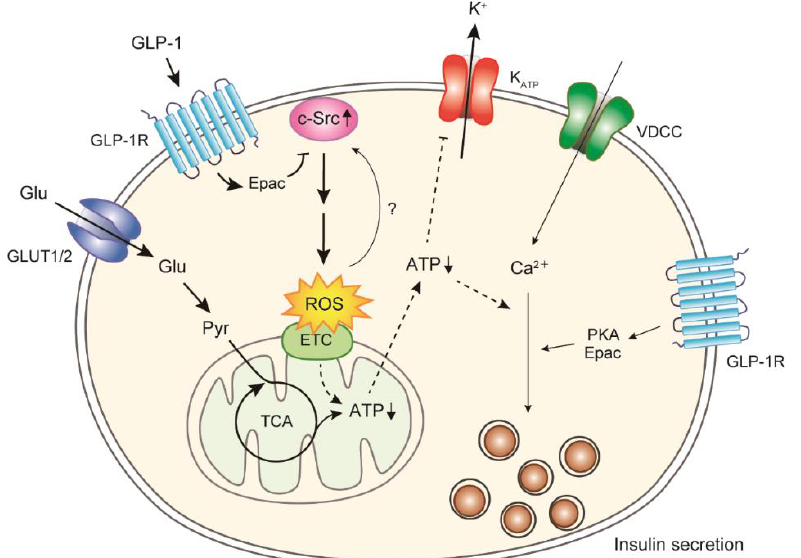
Figure 2. Involvement of c-Src in glucose-induced ROS generation in diabetic β -cells. In diabetic β -cells, acute ROS generation induced by glucose is upregulated, which is attributed to c-Src activa- tion. GLP-1 signaling can suppress c-Src activation and ROS generation, resulting in restored ATP production. Glu, glucose; Pyr, pyruvate; ETC, electron transport chain.